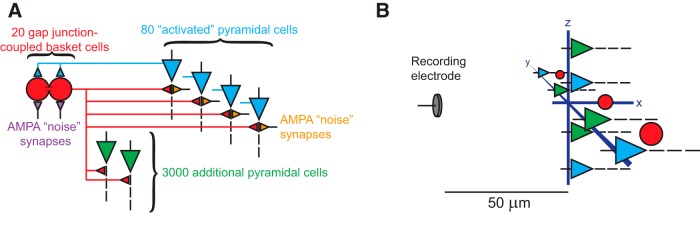
Schematic of the computational model of hippocampus. A, The model consisted of 3080 pyramidal cells and 20 basket cells. Eighty of the pyramidal cells received noisy synaptic input that excited the cells and could produce action potentials. Each basket cell was coupled with gap junctions to the nearest neighboring basket cells, and each sent GABAergic connections to all pyramidal cells. Basket cells received feedback AMPAergic connections from activated pyramidal cells, and they also received noisy synaptic input. All noisy input was independent from cell to cell throughout the network. B, All cells were distributed uniformly along two perpendicular axes in a plane 50 μm from the simulated recording electrode. The furthest cells were located 215 μm from the recording electrode. The voltage recorded by the electrode was generated by summing the voltage produced by the transmembrane current from every compartment of every neuron and interneuron.